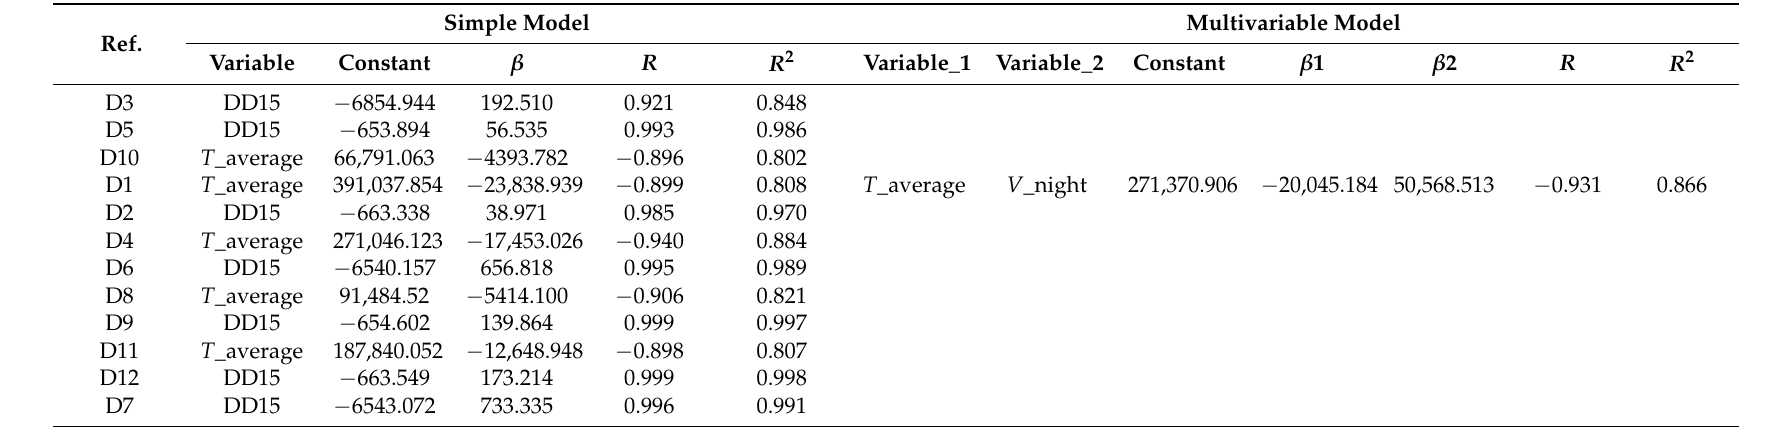
Table 12. Regression